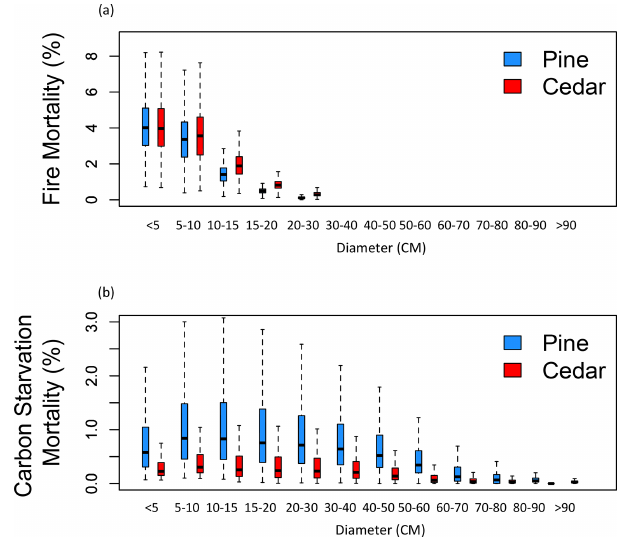
Figure 10. Pine and incense cedar fire mortality (a) and carbon star- vation mortality (b) from smallest to largest size classes. Each box plot shows the annual mortality over 100 years, pooled across the four FATES simulations with the PFT parameterizations that met the criteria in Table 2. Boxes bound the first and third quartiles, hor- izontal lines mark the median and whiskers extend to the max and min